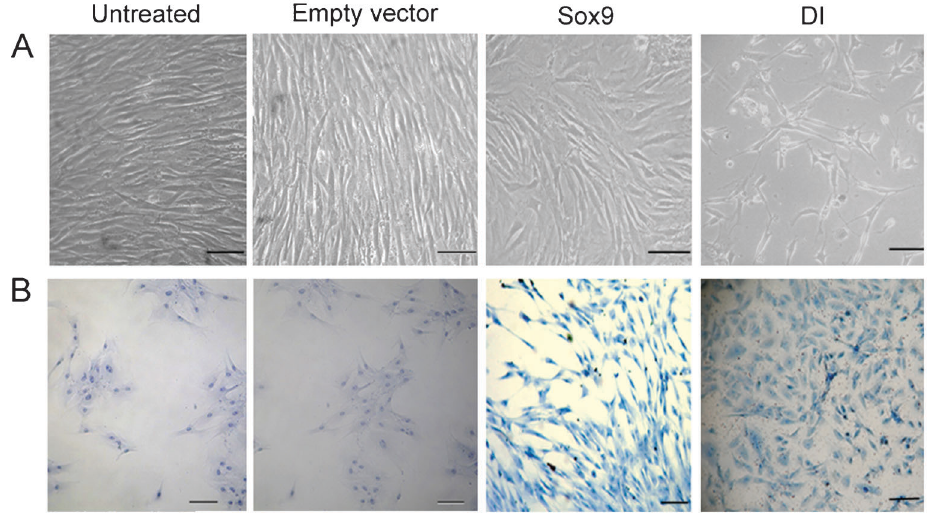
Figure 2. Effects of Sox9 overexpression on morphological changes and proteoglycan disposition in hUC-MSCs. A , Untreated hUC- MSCs and those transfected with empty vector or Sox9-expressing plasmid had a similar fibroblast-like morphology. In contrast, hUC- MSC cells cultured in the chondrogenic medium (differentiation-induced group: DI) for 48 h were polygonal or irregular in shape and prone to detach from the plate. Bar = 50 m m. B , Assessment of proteoglycan disposition by toluidine blue staining. The degree of toluidine blue staining was low in untreated and empty vector-transfected control hUC-MSC cells with basic maintenance medium. After 2-3 weeks of monolayer culture, Sox9-transfected hUC-MSCs and those treated with chondrogenic medium (DI) showed strong toluidine blue staining. Bar = 100 m